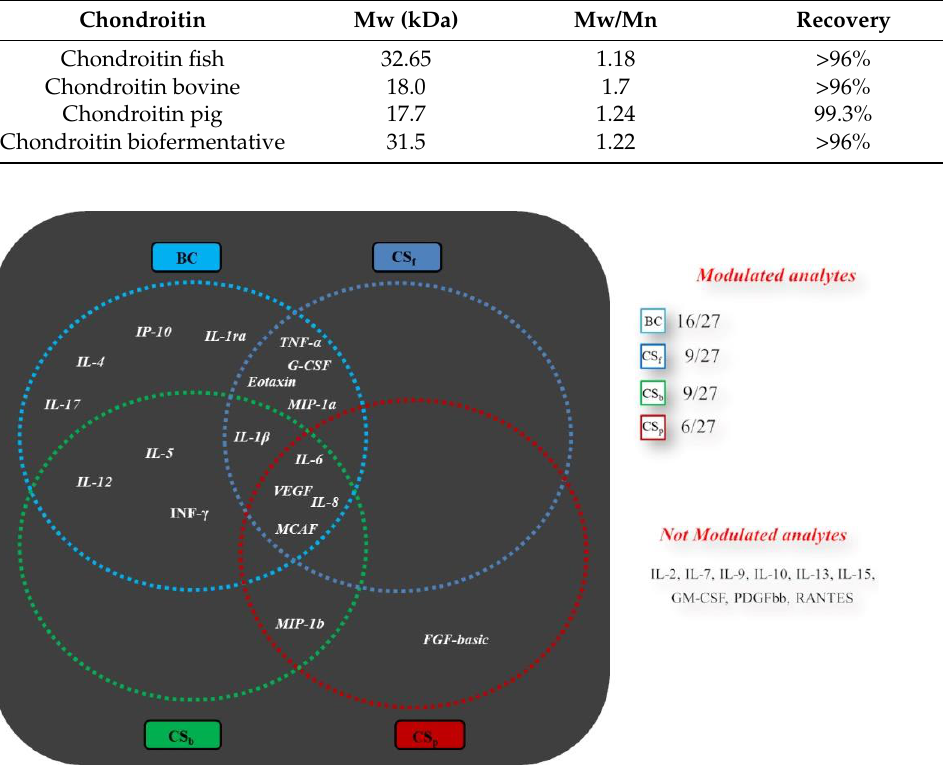
Figure 1. Schematic representation of biomarkers modulated by all the extractive and biofermentative chondroitins. The analysis was performed by multiplex assay. Fold Change considered vs. pCTRL: ≥ 1.20 or ≤